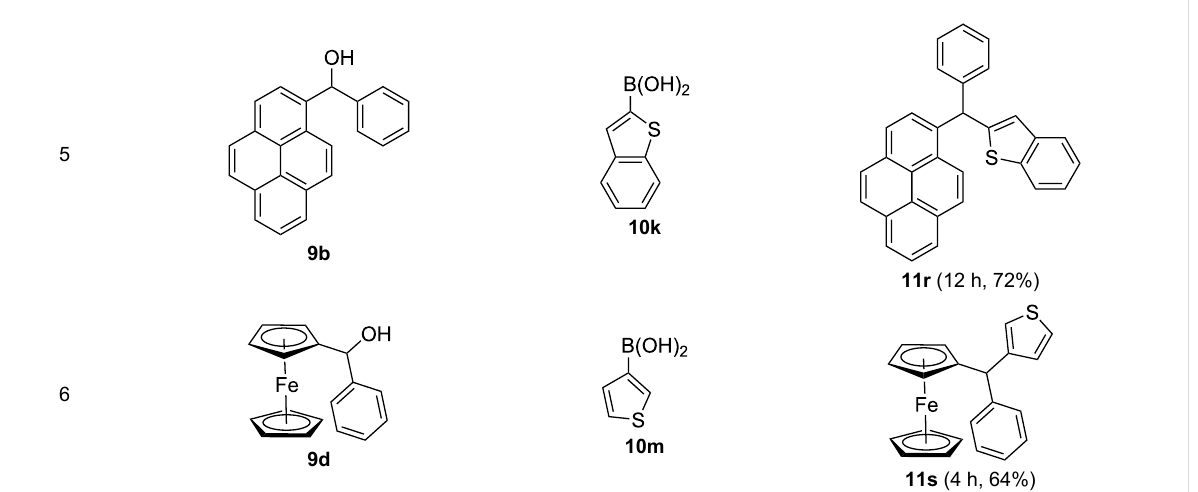
Table 3: Scope of diarylmethanol 9b–d in the copper-catalyzed coupling reaction.